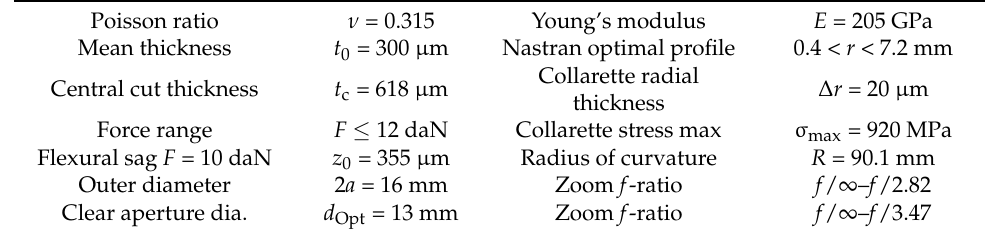
Table 2. Results from optics and elasticity parameters of the tulip-like VCM modeling. Poisson ratio ν =